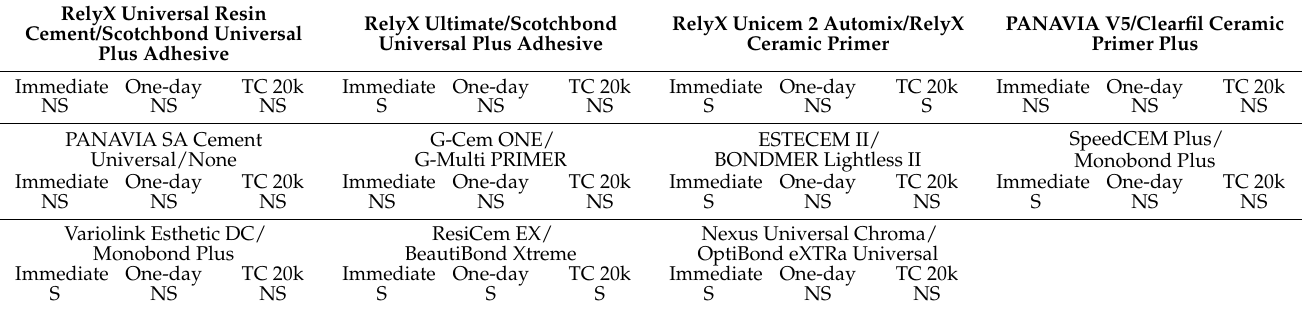
Table 6. Comparison of the results (by t -test) for shear bond strength to LDS (e.max) of each adhesive resin cement material with regard to two curing